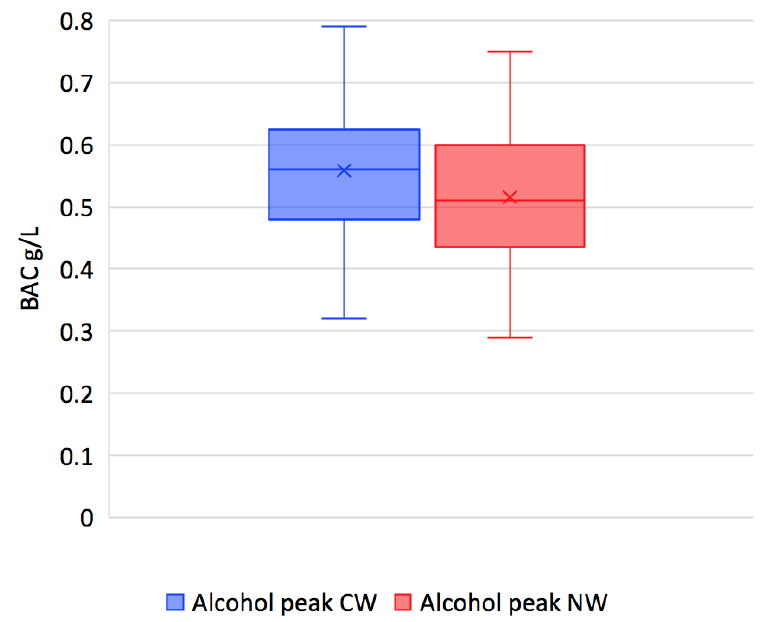
overlap toward the end.